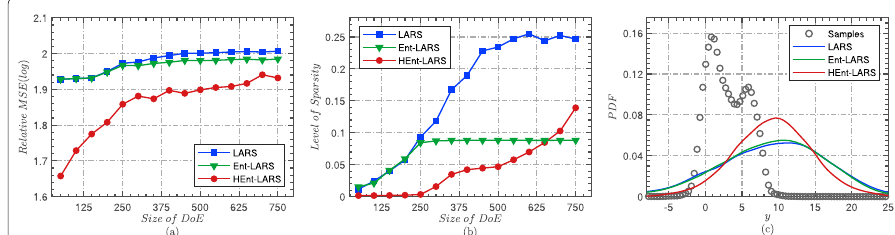
Fig. 7 Performance comparison of LARS, Ent-LARS and HEnt-LARS w.r.t. the OAKLEY & O’HAGAN function. ( a ) The relationship between the relative MSE and the size of DoE; ( b ) The relationship between the